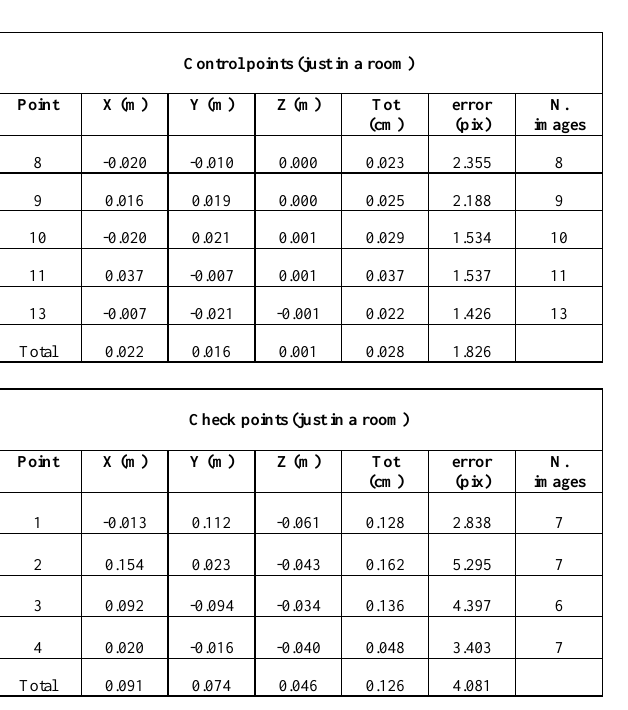
Table 3. Results using only targets in the first room as control points. Targets in the second room are used as check points.